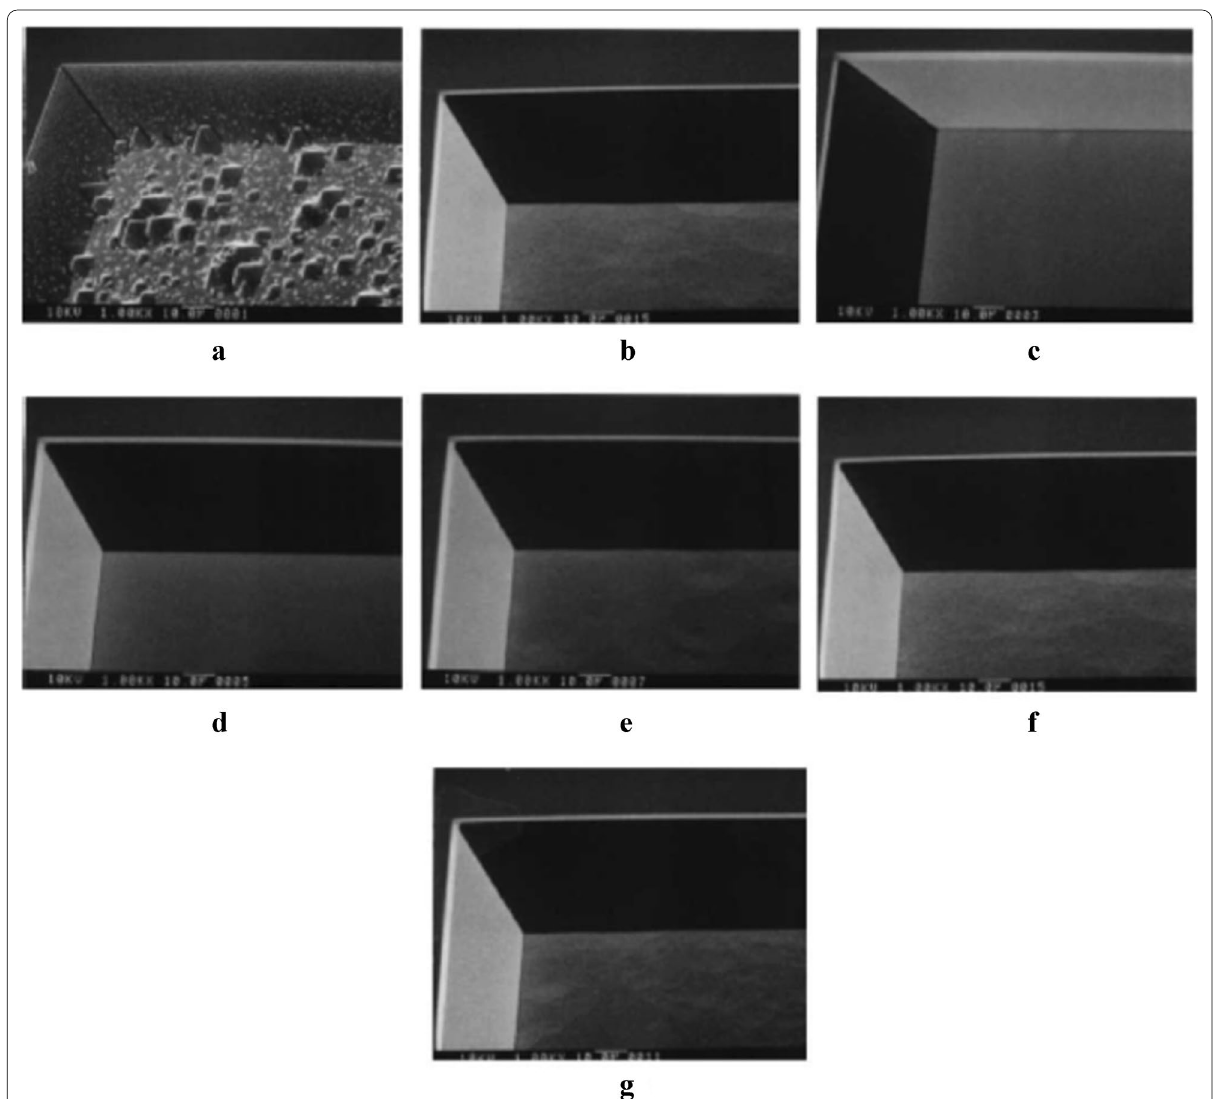
Fig. 37 SEM photographs of etched Si{100} in 3.2 wt.% Si dissolving 10 wt.% TMAH at 80 °C with addition of a 0 wt%, b 0.2 wt%, c 0.4 wt%, d 0.6 wt%, e 0.8 wt%, f 1.0 wt%, g 1.2 wt%, ammonium persulfate (AP) [108], © 2004,